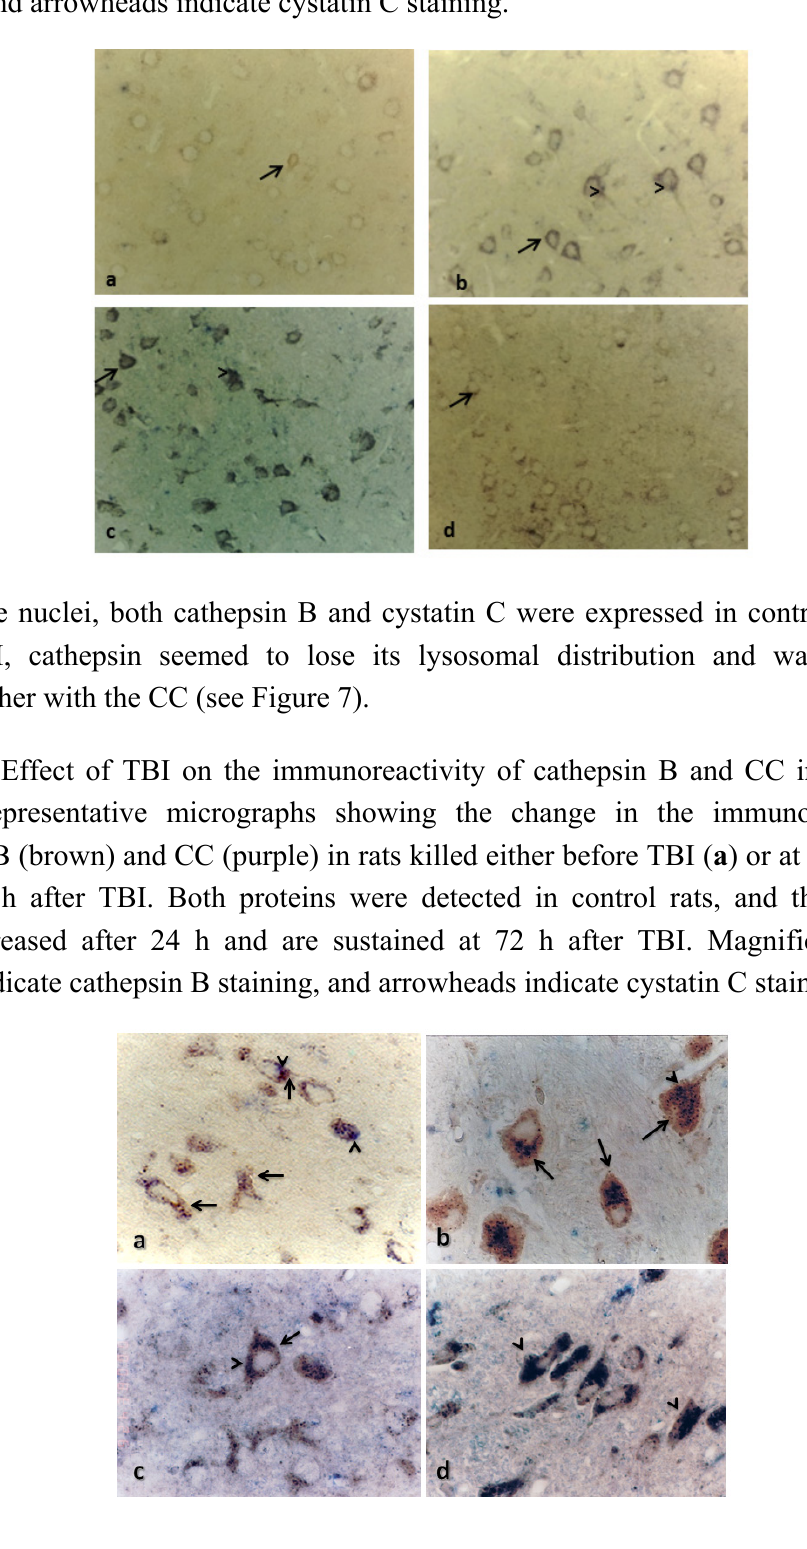
Figure 6. Effect of TBI on the immunoreactivity of cathepsin B and CC in the retrosplenial agranular cortex. Representative micrographs showing the change in immunoreactivity of cathepsin B (brown) and CC (purple) in rats killed either before TBI ( a ) or at 24 ( b ), 48 ( c ) or 72 ( d ) h after TBI. Cathepsin B was detected in the brains of control rats, and the expression level increased 24 h after TBI and decreased after 72 h, whereas CC was only detected after TBI. Magnification: 20× ( a , c , d ); 40× ( b ). Arrows indicate cathepsin B staining, and arrowheads indicate cystatin C staining.